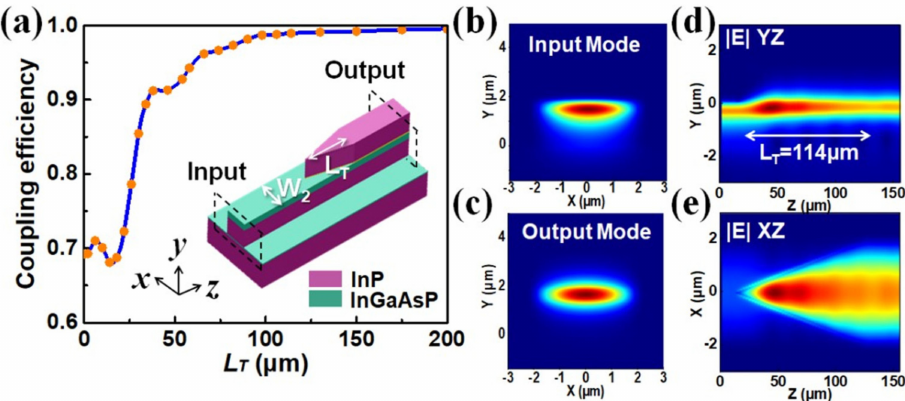
Figure 7. ( a ) The mode connection efficiency for the top taper in the active waveguide device as a function of the taper length L T . ( b ) Simulated 2D profile of the input mode. ( c ) Simulated 2D profile of the output mode. ( d ) Horizontal cross-section illustrating the behavior of the propagating beam in the taper with L T = 114 µ m. ( e ) Vertical cross-section illustrating the behavior of the propagating beam in the taper with L T = 114 µ